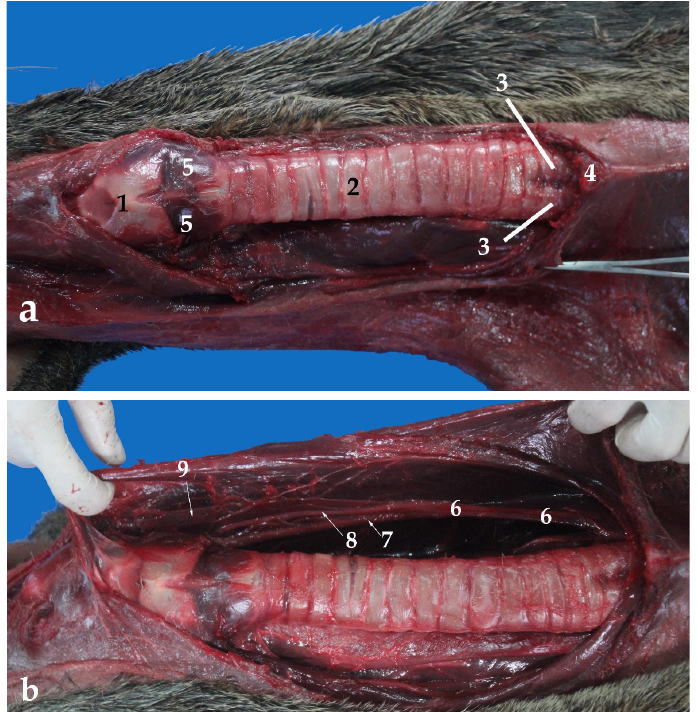
Figure 5. Dorsal view of the neck: ( a ) superficial view, ( b ) deeper view with the carotid sheath in detail, (1) larynx; (2) trachea; (3) bronchi; (4) sternal manubrium; (5) thyroid gland; (6) carotid sheath (opened); (7) common carotid artery; (8) vagosympathetic trunk; (9) internal jugular vein. Table 1. Morphometric data of the trachea from the 11 individuals of Arctocephalus australis investi- gated in the present study. A: adult; J: juvenile.